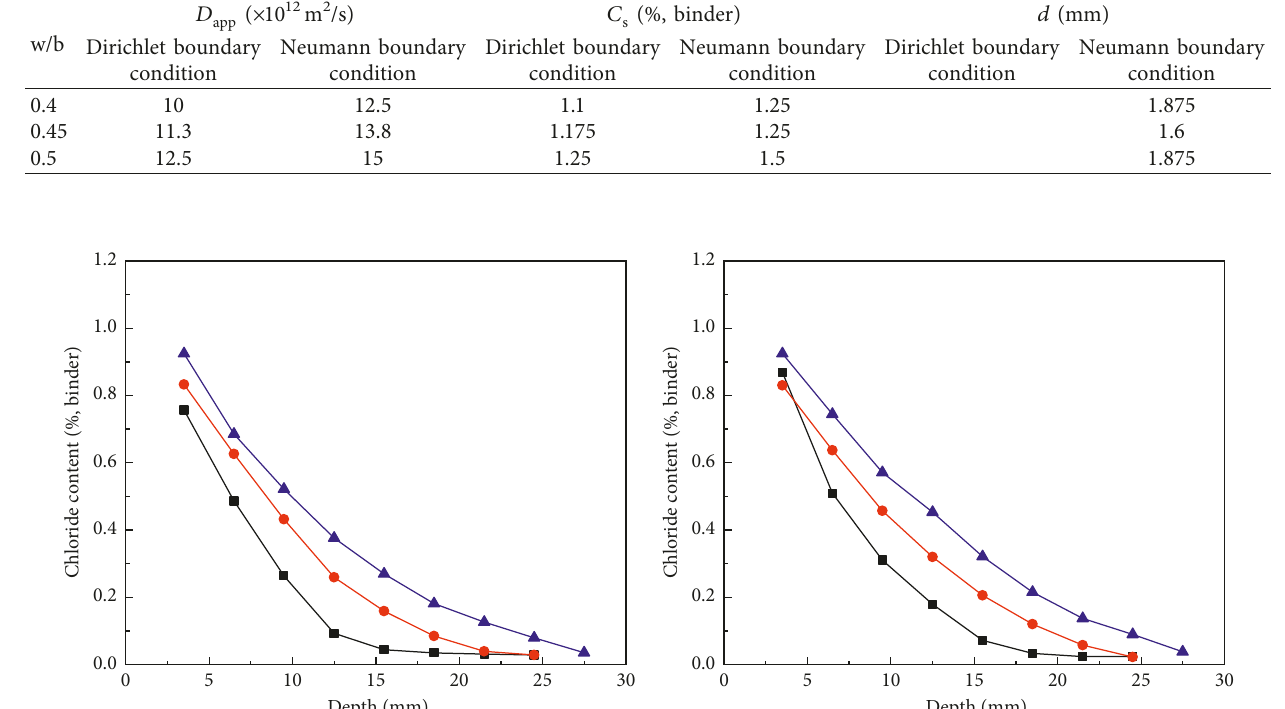
, C , and d with two boundary conditions. app s